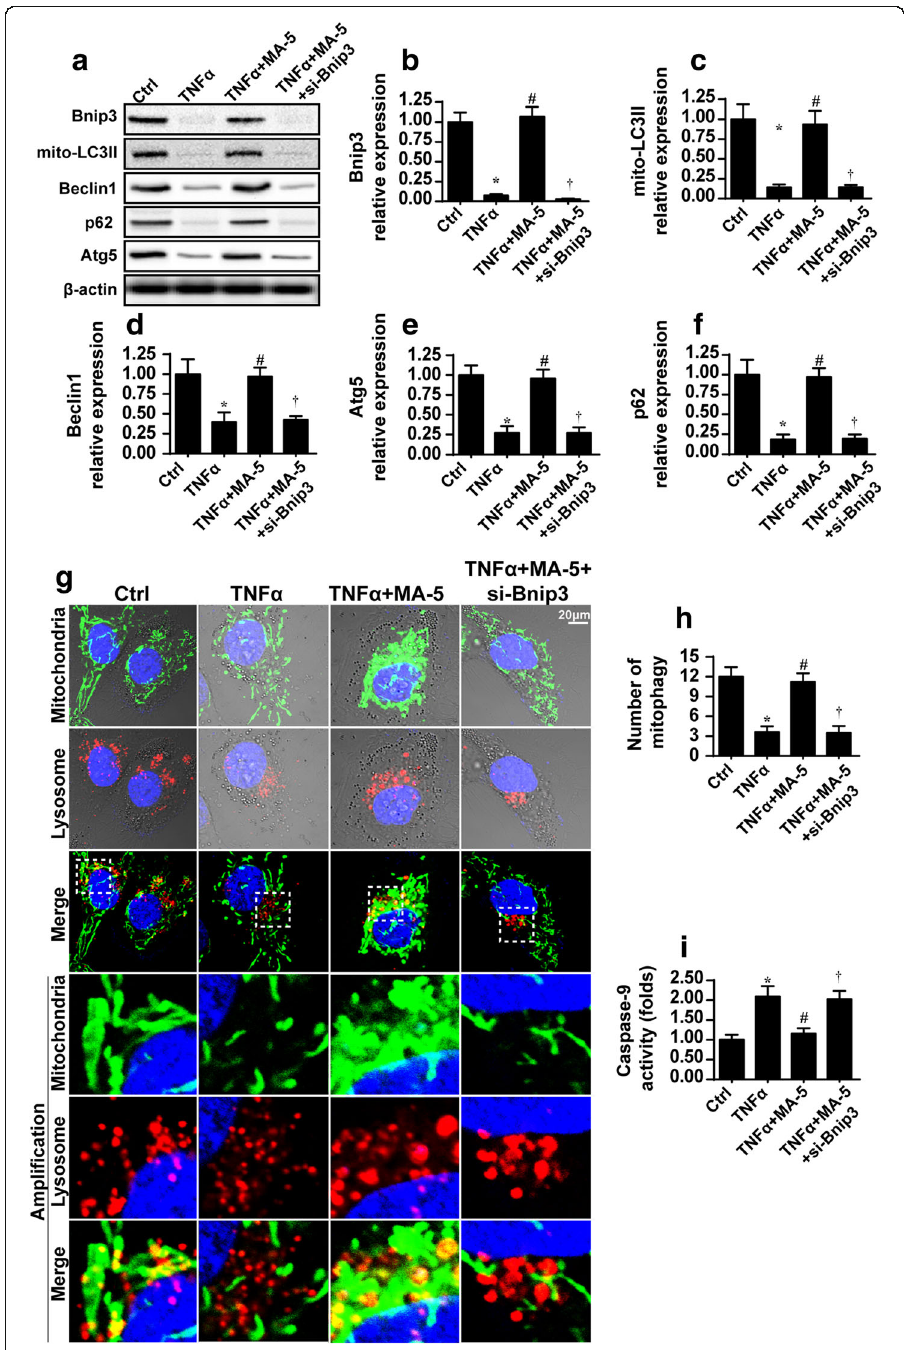
Fig. 3 MA-5 enhanced mitophagy via Bnip3. a through f The proteins were isolated and analyzed via western blotting. The mitophagy parameters were evaluated in control cells (Ctrl), and in cells treated with 10 ng/ml TNF α (TNF α ), 10 ng/ml TNF α and 5 μ M MA-5 (TNF α +MA-5), or 10 ng/ml TNF α and 5 μ M MA-5 after silencing of Bnip3 with an siRNA (TNF α +MA-5 + si-Bnip3). g and h An immunofluorescence assay of mitophagy via mitochondria and lysosome co-staining in cells treated with 10 ng/ml TNF α (TNF α ), or 10 ng/ml TNF α and 5 μ M MA-5 (TNF α +MA-5). i The caspase-9 activity with MA-5 treatment (TNF α +MA-5) or Bnip3 knockdown (TNF α +MA-5+si-Bnip3). * p <0.05 vs. Ctrl group; # p <0.05 vs. TNF α group; † p <0.05 vs. TNF α +MA-5